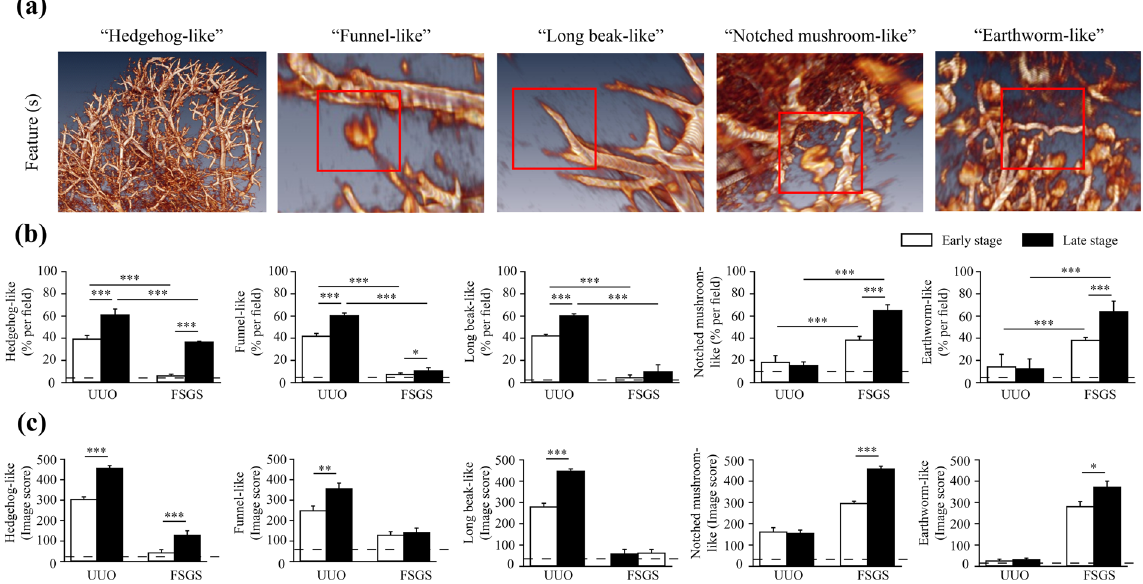
Figure 3. Characteristic 3D imaging markers distinguish early or late stages of the renal lesions in UUO and FSGS mice. ( a ) Five images were identified: hedgehog-like, funnel-like, long beak-like, notched mushroom-like and earthworm-like (each highlighted in square). ( b ) The quantitative results were shown as the percentage of hedgehog-like, funnel-like, long beak-like, notched mushroom-like and earthworm-like images per field. ( c ) Image score of hedgehog-like, funnel-like, long beak-like, notched mushroom-like and earthworm-like images for UUO or FSGS. The horizontal dashed line indicates the level of the normal control mice. UUO-unilateral ureteral obstruction; FSGS-focal segmental glomerulosclerosis. n = 7 mice per group. * p < 0.05, ** p < 0.01, *** p <